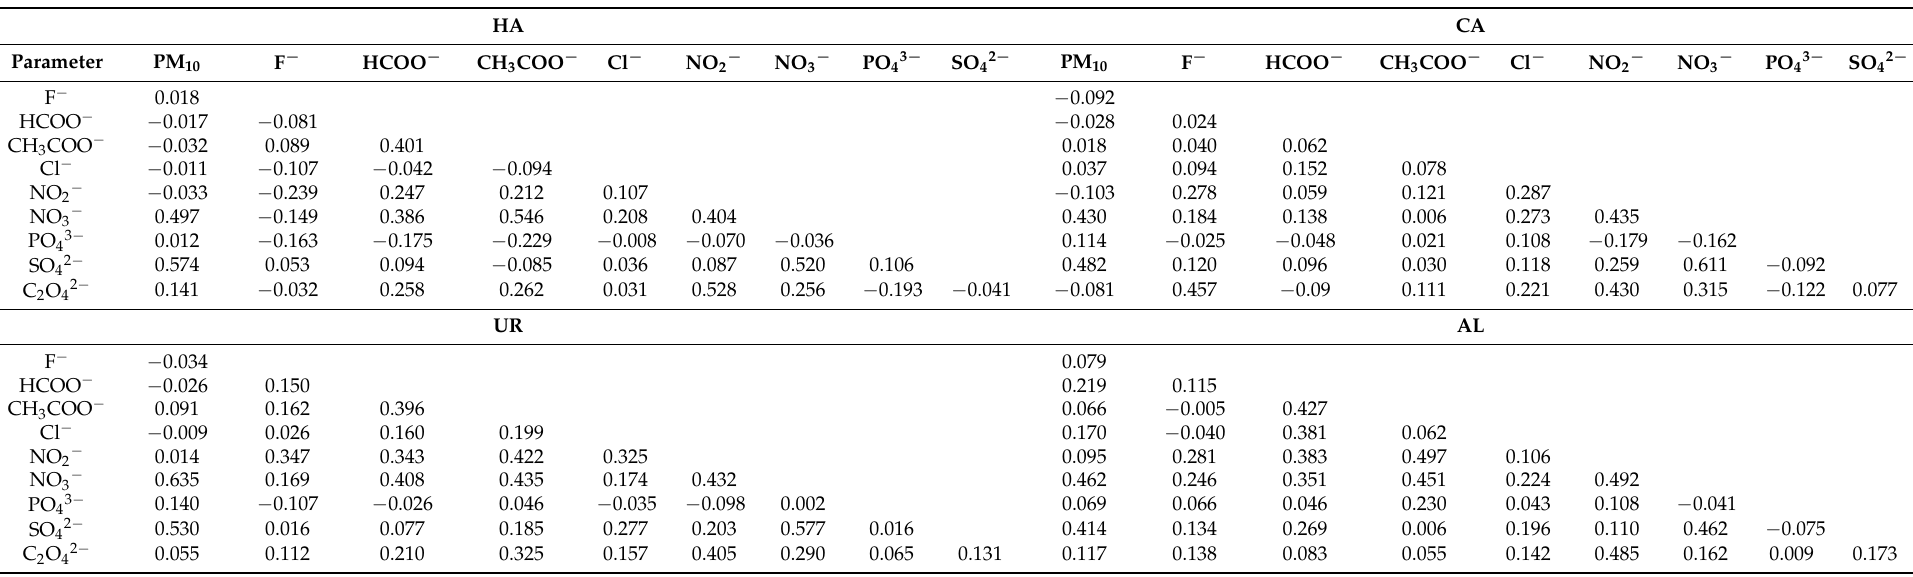
Table 5. Spearman correlation coefficients for PM 10 and ions evaluated in the sampling sites for a confidence level of 95%, 2011–2018.